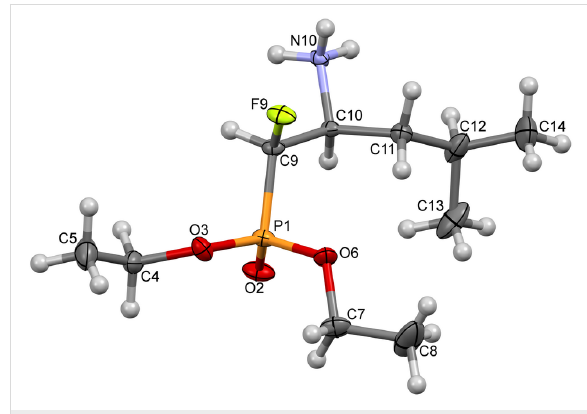
Figure 3: Molecular structure of compound (1 R ,2 S )- 14c (ORTEP image).